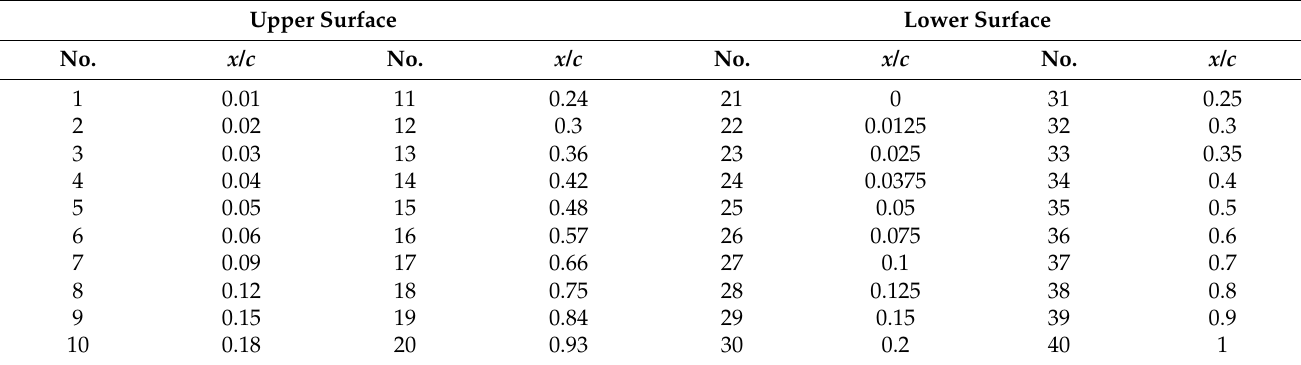
Table 1. Locations of the pressure transducers on the OA209